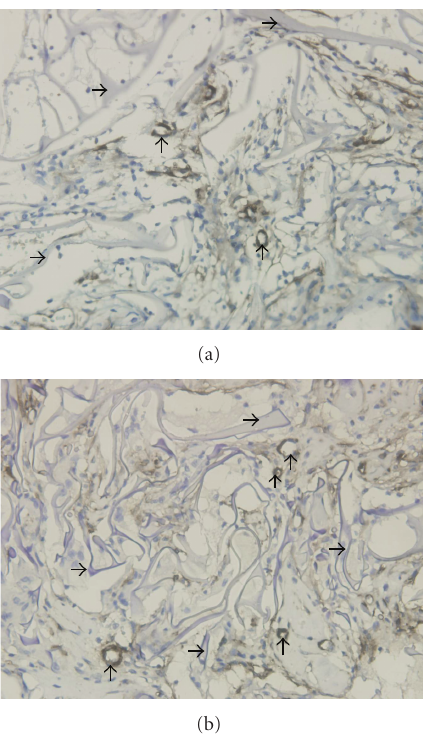
Figure 3: The images of HEs stained tissue ( × 400). (a, b are the images at 7d, 20d after implantation; ↑ : arteriole; → : porous silk fibroin film).